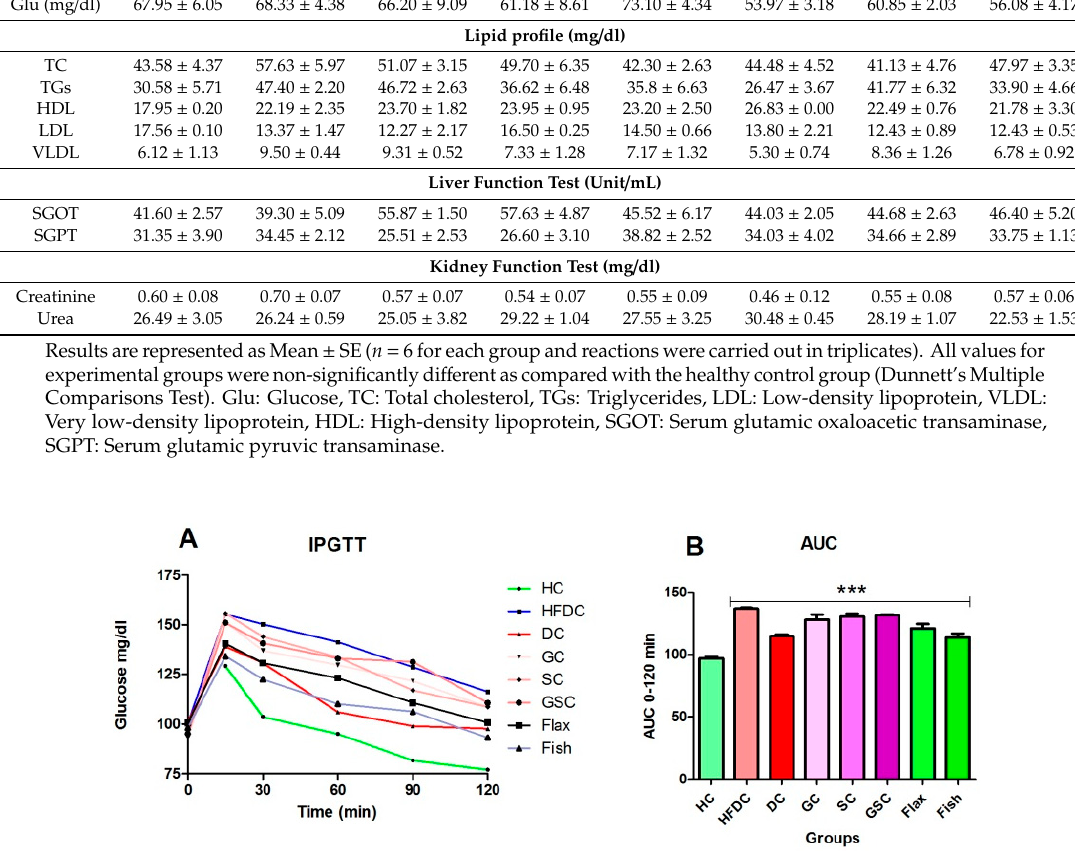
Table 6. Serum glucose and insulin for HOMA-IR assessment.